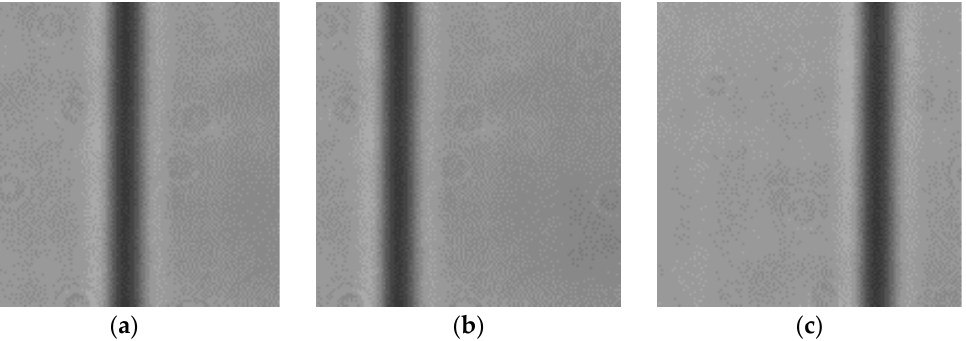
Figure 14. Different shift of gold lines in the images. ( a ) No shift; ( b ) Shift to the left; ( c ) Shift to the right. Table 3. The MSE and MAE of Focus & TSOM-CNN on two shifted gold line test sets and a no shift test set.